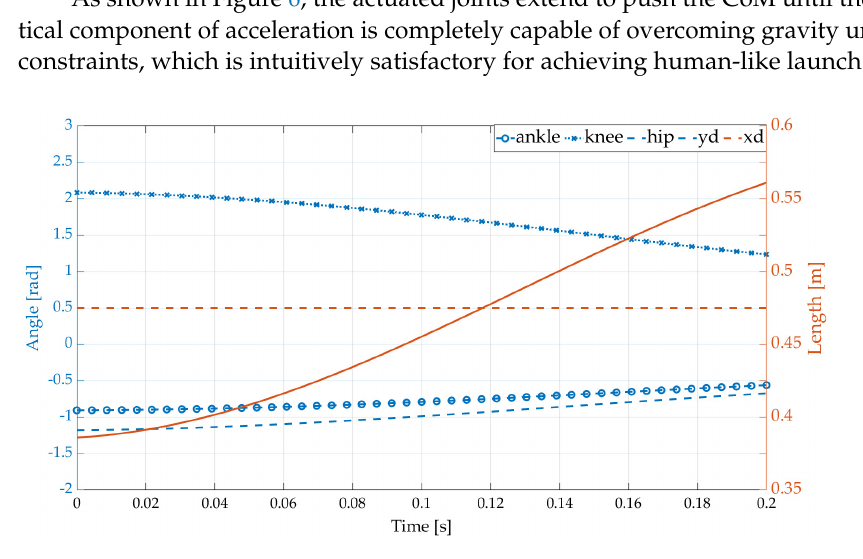
Figure 6. Trajectory of the actuated joints and CoM in the vertical component.